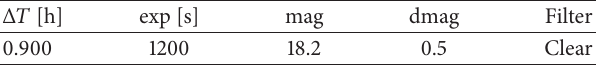
Table 14: GRB 121024A: observing log of